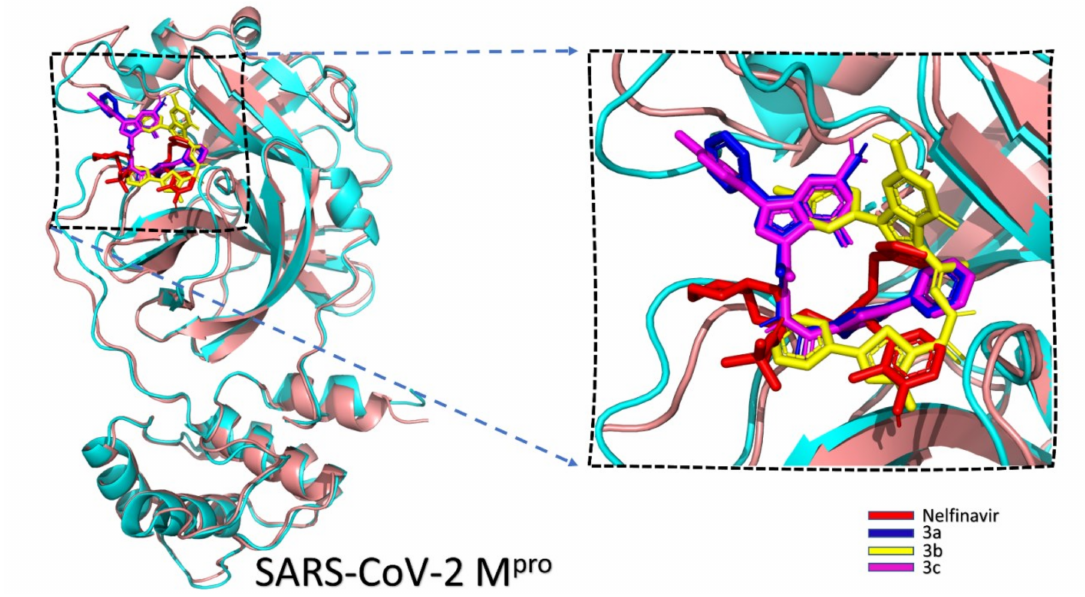
Figure 4. The superposition of the positive control (Nelfinavir) and the best three compounds, 3a , 3b , and 3c , depicted using PyMOL software. The compounds are shown in colored sticks, and M pro in colored cartoons.